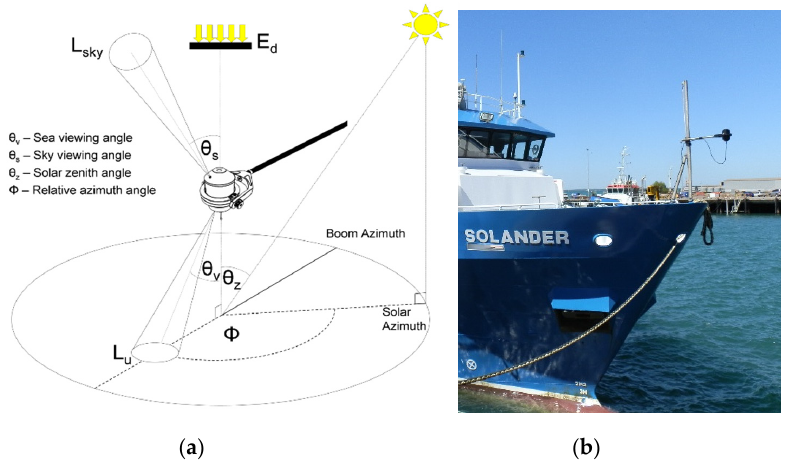
Figure 1. The “dynamic above water radiance and irradiance collector” (DALEC) hyperspectral radiometer: ( a ) Instrument schematics and measurement geometry (courtesy of in situ Marine Optics) ( b ) instrument mounted on RV Solander.